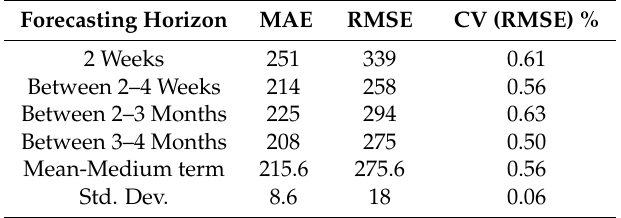
Table 6. Performance Metrics of LSTM-RNN on various Time